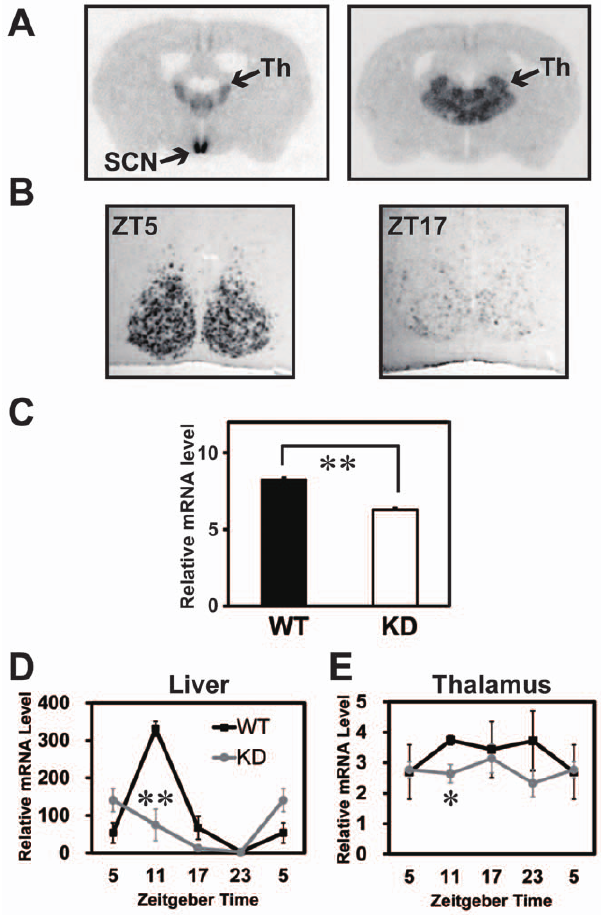
Figure 1. Spatial and temporal expression patterns of the Rgs16 mRNA in brain and its reduction in the KD mice. A, B, in situ hybridization performed on brain sections. A, Specific and intense signals were observed in the SCN and thalamus (Th). B, Diurnal rhythms of the Rgs16 transcript were observed in the SCN. C, ISH quantification of the Rgs16 mRNA in the KD and WT SCN (n=8 each) at ZT5. ** P , 0.01 vs. WT (Student’s t -test). D, Expression of Rgs16 in the KD and WT liver observed by qPCR. ** P , 0.01 vs. WT (Student’s t -test). ## , P , 0.01 circadian gene expression profile by 2-way ANOVA (WT vs. KD mice; n=3–4). E, Expression of Rgs16 in thalamus of the KD and WT mice (n=3–4). * P , 0.05 vs. WT.